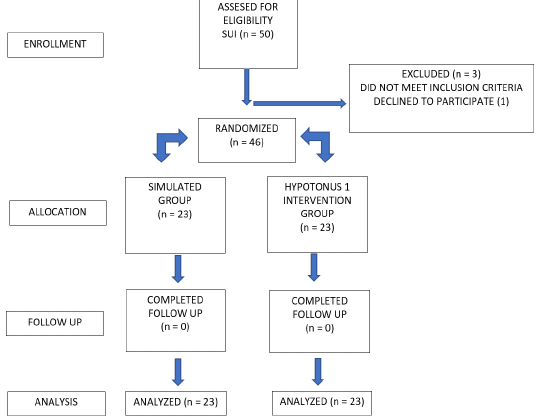
Figure 1. Flow chart of patient’s study enrollment, allocation and follow up. Table 1. General characteristics of the patients according to the assigned treatment.